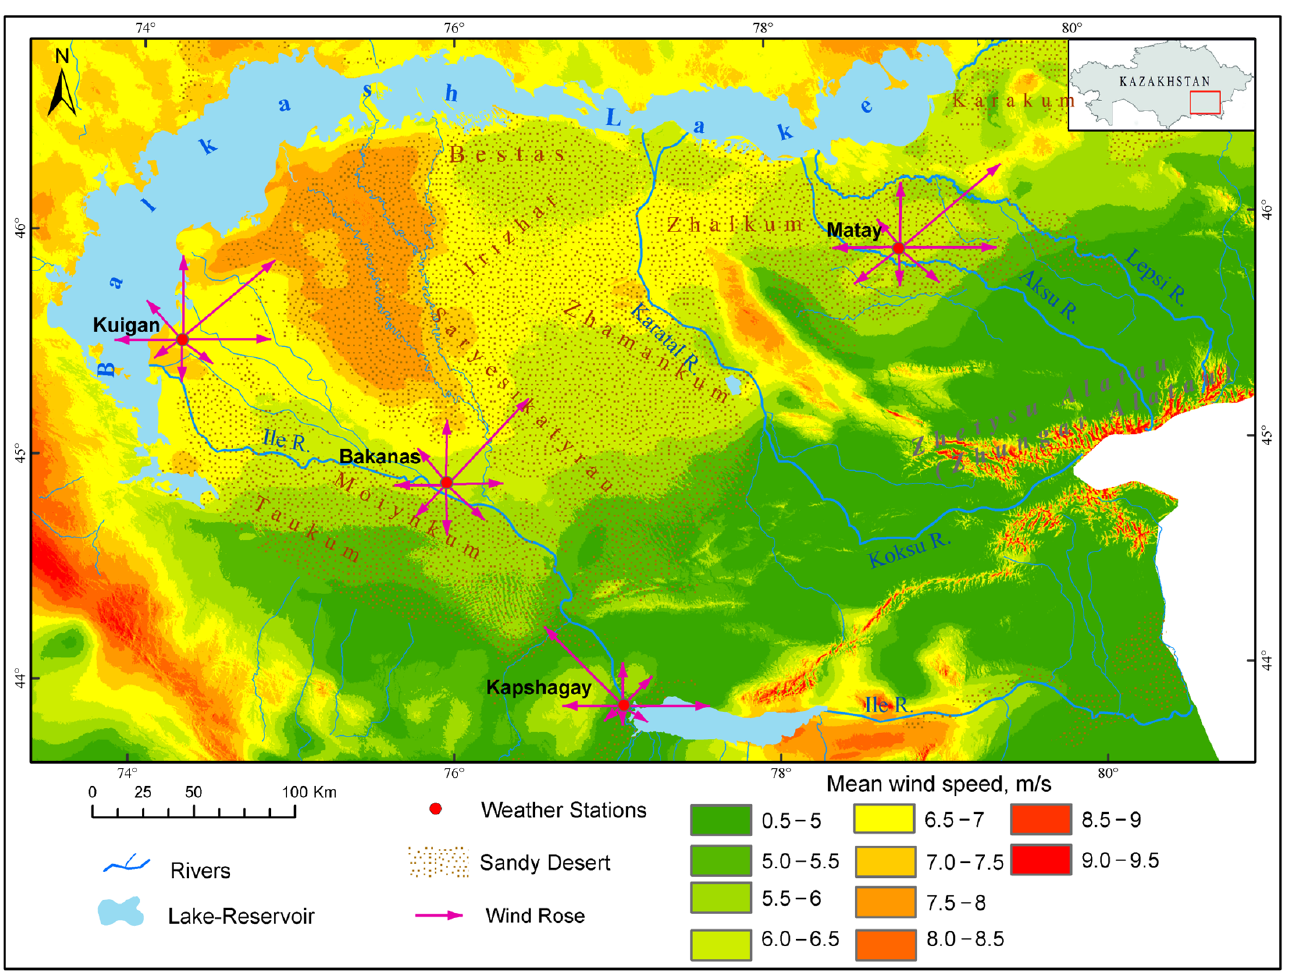
Figure 5. Spatial wind speed and its directions in the Southern Balkash deserts.